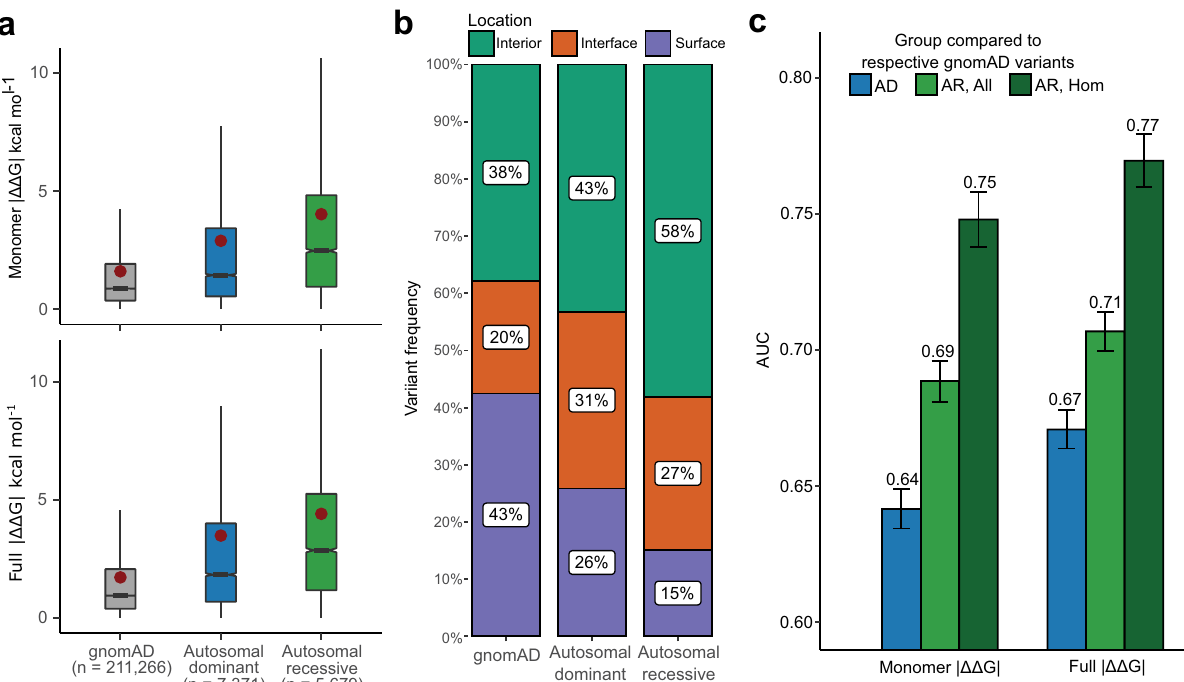
Fig. 2 Autosomal dominant mutations are milder than autosomal recessive mutations. a Comparison of predicted | ΔΔ G | values for gnomAD variants and pathogenic ClinVar mutations from autosomal dominant (AD) and autosomal recessive (AR) genes. Boxes denote data within 25th and 75th percentiles, and contain median (middle line) and mean (red dot) value notations. Whiskers extend from the box to furthest values within 1.5x the inter- quartile range. All pairwise comparisons between groups are signi fi cant (p < 6.4 × 10 − 72 , two-sided Holm-corrected Dunn ’ s test). b Proportions of gnomAD, AD and AR mutations occurring in protein interiors, surfaces and interfaces. All pairwise comparisons are signi fi cant (Chi-square test). c AUC values calculated from ROC curves for discriminating between pathogenic ClinVar mutations from AD or AR genes, and putatively benign gnomAD variants. ‘ AR, All ’ considers all gnomAD variants from the AR genes, while ‘ AR, Hom ’ only includes those variants that have been observed in a homozygous state in gnomAD at least once. Error bars denote 95% con fi dence intervals. Source data are provided as a Source Data fi